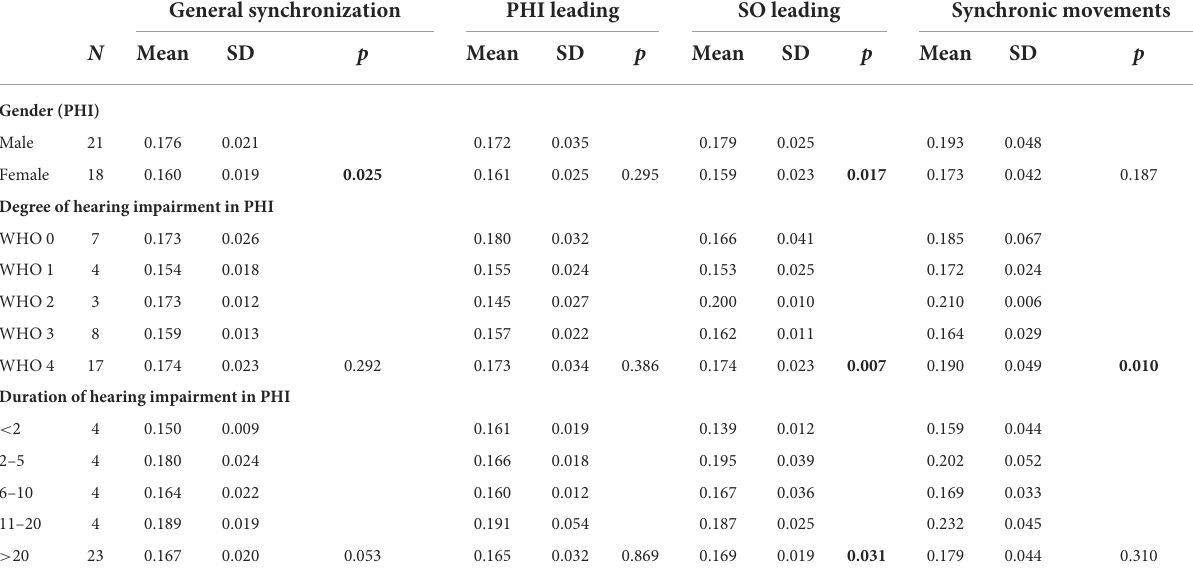
TABLE 2 Nonverbal synchrony, gender, degree, and duration of hearing